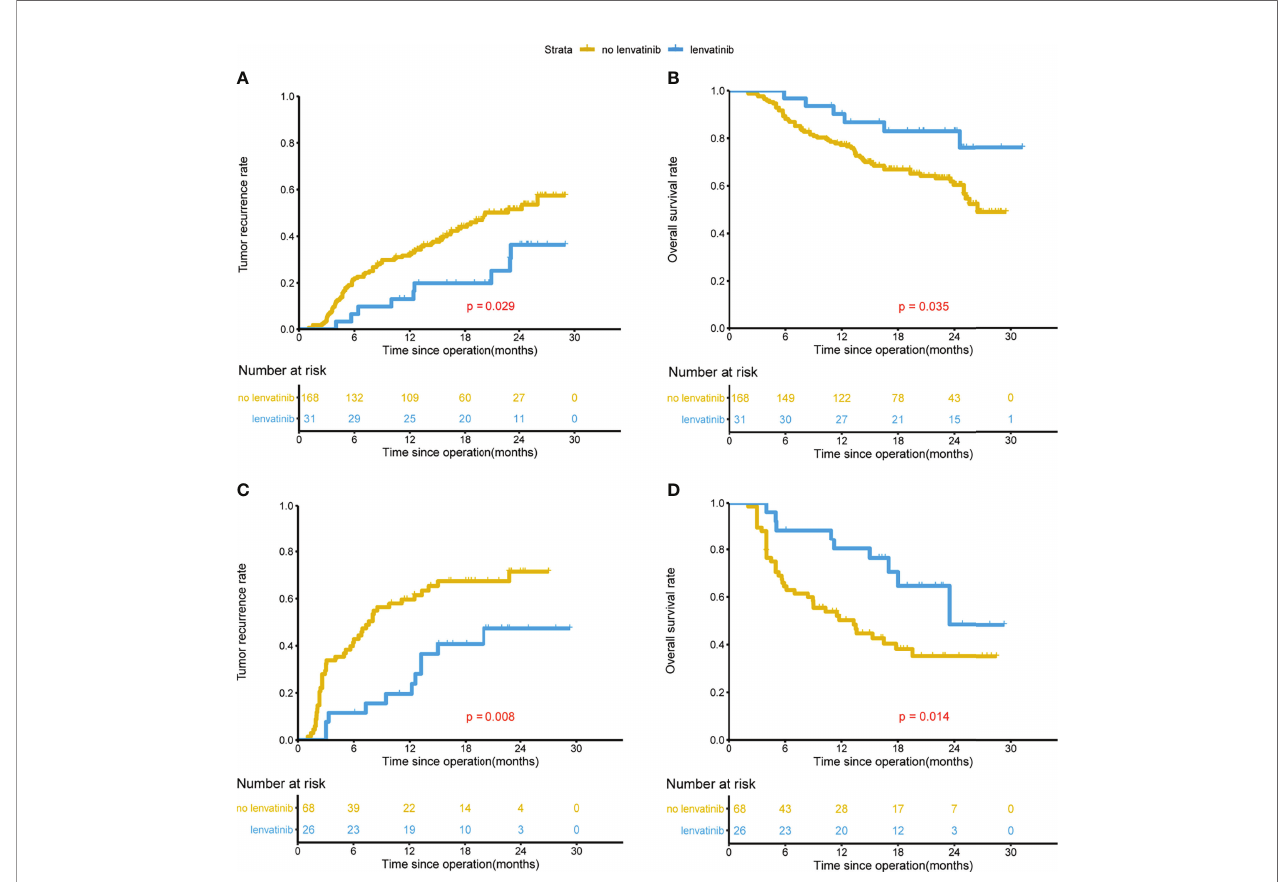
FIGURE 2 | Kaplan-Meier analysis for predicting survival in HCC patients with MVI beings M1 and M2 after radical resection. MVI beings M1, TTR and OS for patients with and without adjuvant Lenvatinib (A, B) . MVI beings M2, TTR and OS for patients with and without adjuvant Lenvatinib (C, D)